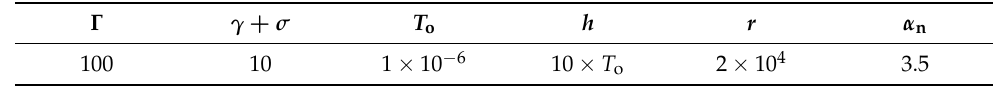
Table 2. Associated design parameters of the different control laws.